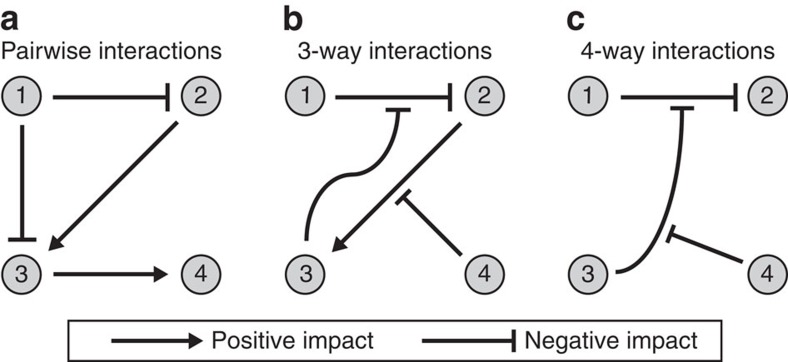
Species can exhibit high-order interactions, whereby the interaction between two species is affected by other species.(a) Pairwise interactions in a community: species affect each other directly. For instance: species ‘1' could be producing an antibiotic, inhibiting the growth of species ‘2'. (b) Three-way interactions in a community: one species can modulate the interactions between two others. For instance, species ‘3' might degrade the antibiotics produced by species ‘1', thereby attenuating the inhibitory effect of species ‘1' on species ‘2'. (c) Four-way interactions in a community. For example, species ‘4' might produce a compound that inhibits the antibiotic-degrading enzyme produced by species ‘3'.